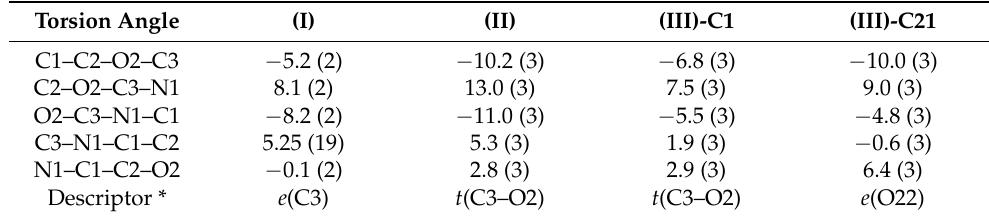
Table 1. Key ring torsion angles ( ◦ ) in ( I )–( III